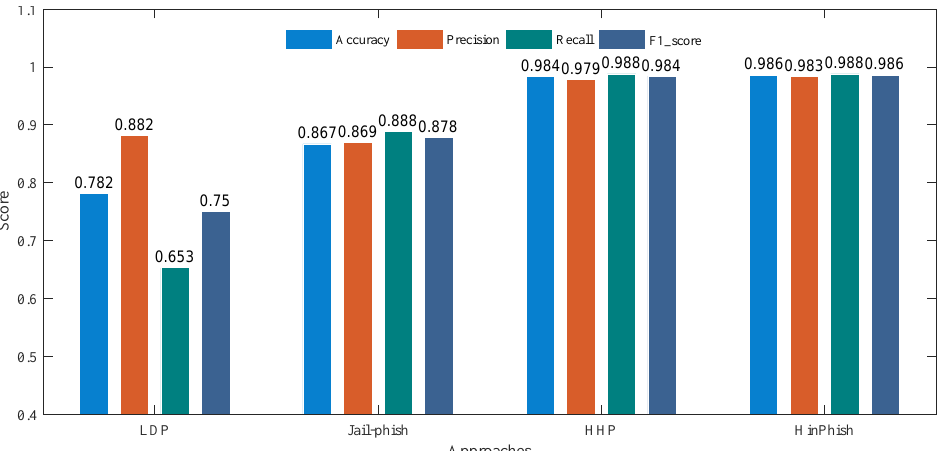
Figure 8. Comparison of HinPhish with Search Engine-based